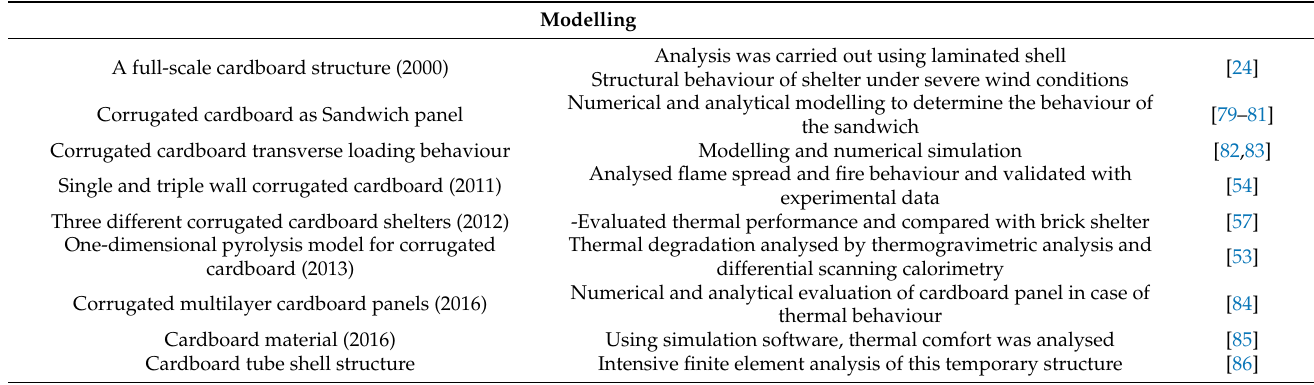
Table 5. Previous research on the numerical and analytical evaluation of cardboard